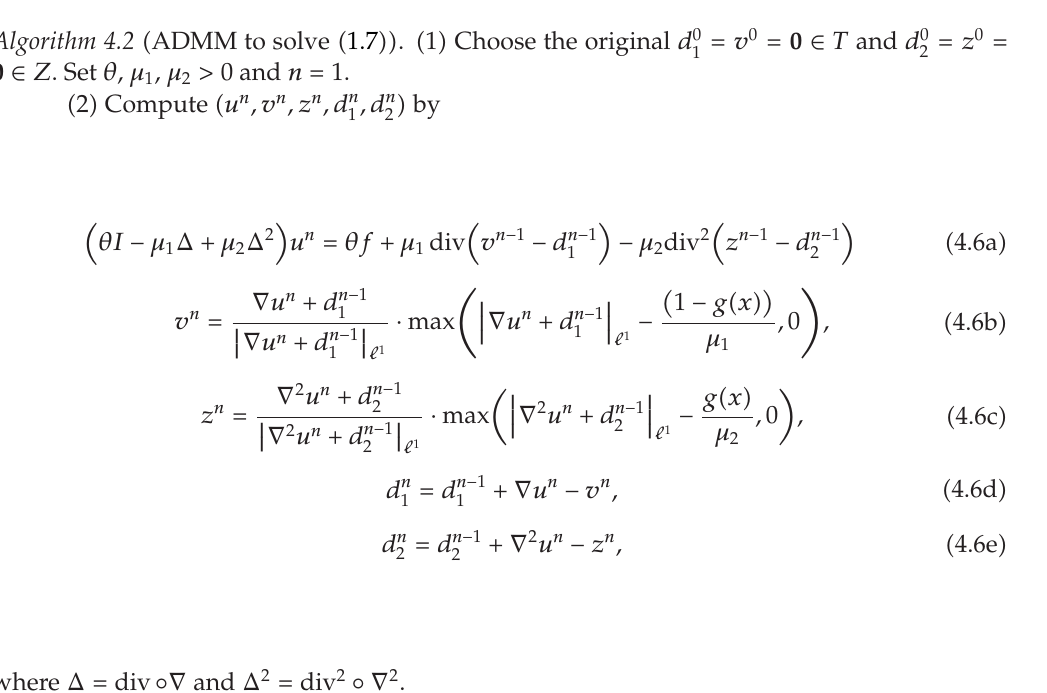
Algorithm 4.2 (cid:3) ADMM to solve (cid:3) 1.7 (cid:4)(cid:4) . (cid:3) 1 (cid:4) Choose the original d 0